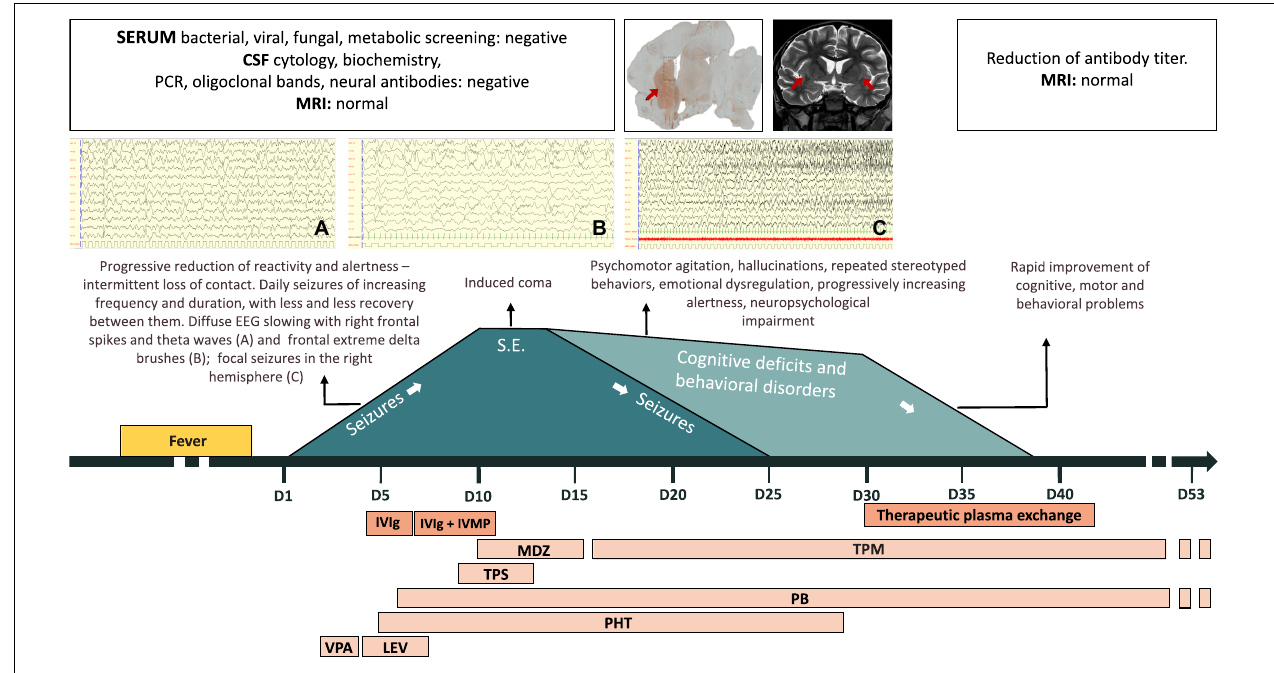
FIGURE 1 | Patient’s clinical course. CSF, cerebrospinal fluid; IVIg, intravenous immunoglobulins; IVMP, intravenous methylprednisolone; LEV, levetiracetam; MDZ, midazolam; MRI, magnetic resonance imaging; PB, phenobarbital; PCR, polymerase chain reaction; PHT, phenytoin; S.E., status epilepticus; TPM, topiramate; TPS, thiopental; VPA,